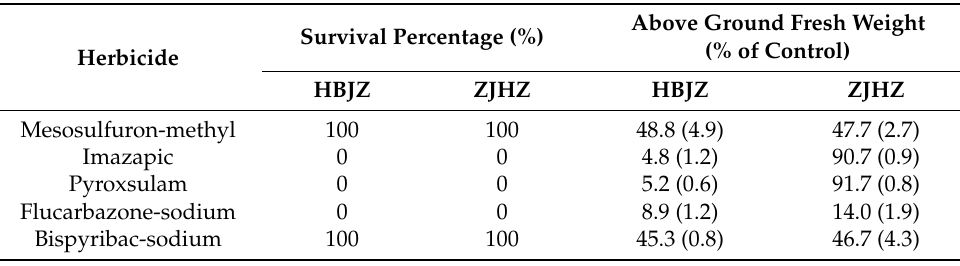
Table 2. Survival percentage (%) and above-ground fresh weight reduction (%) of the HBJZ and ZJHZ R. kamoji populations 21 days after treatment with different ALS